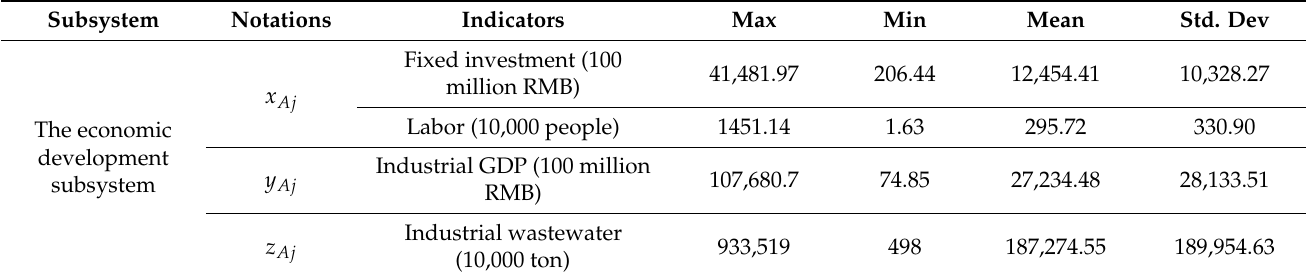
Figure 2. The structure of the industry production system. Table 1. Characteristics of all regional industry system’s inputs and outputs .